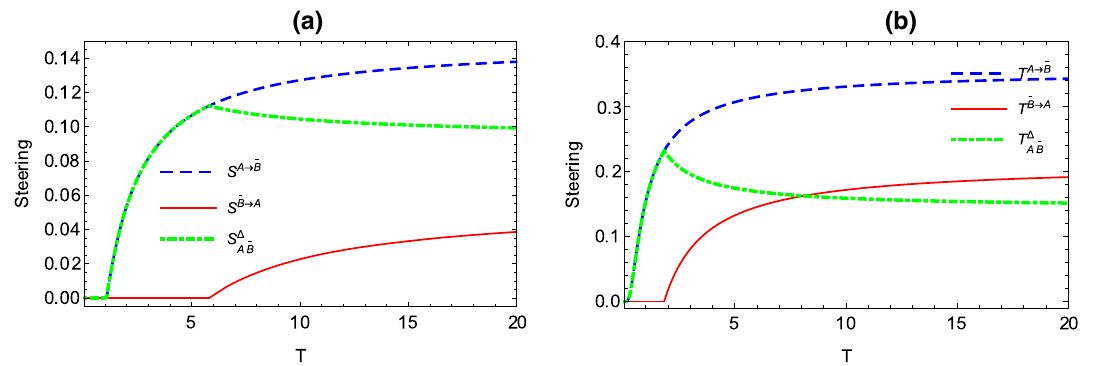
Fig. 2 The fermionic steerability and steering asymmetry between Alice and Anti-Bob as functions of the Hawking temperature T . The parameter ω is fixed as ω = 1 Hawking temperatures for the maximal steering asymmetry are T s ≈ 5 . 8021 ω (Fig. 2a) and T t = ω